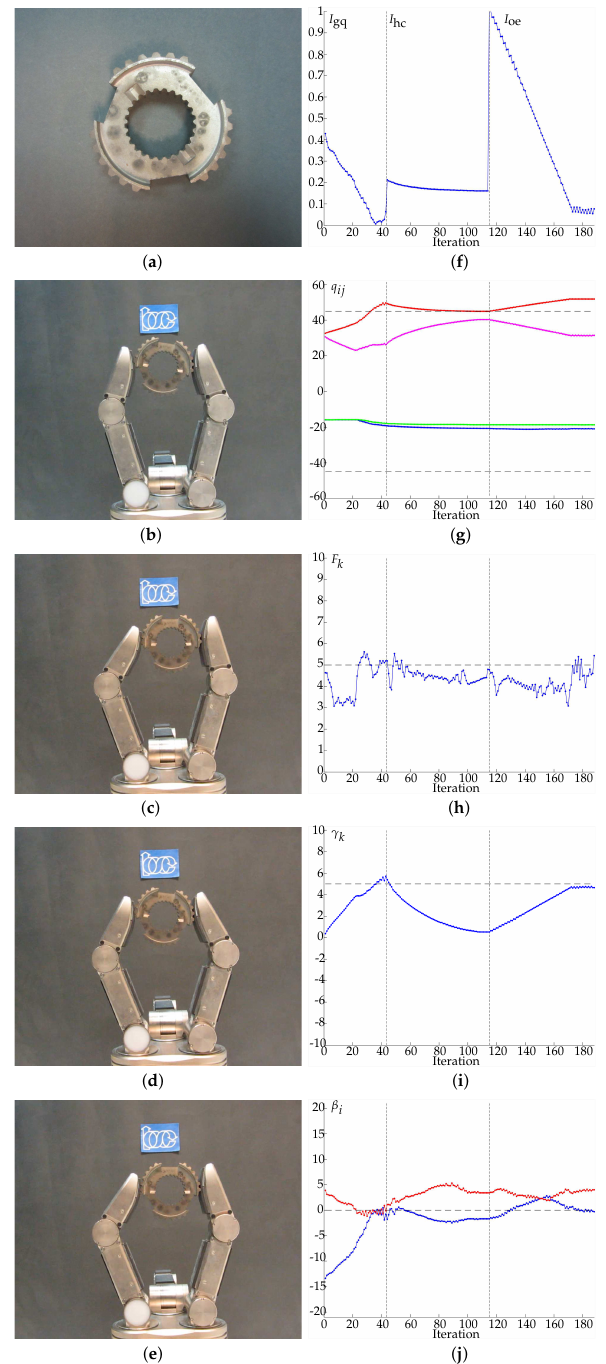
Figure 11. Example 1. ( a ) Manipulated object. ( b ) Initial grasp. ( c ) Hand configuration after optimizing I gq . ( d ) Hand configuration after optimizing I hc . ( e ) Hand configuration after optimizing I oe . ( f ) Evolution of the quality indexes. The manipulations improving I gq , I hc and I oe ended after 3.864 s and 43 iterations, 4.486 s and 70 iterations and 9.083 s and 73 iterations, respectively. ( g ) Evolution of the joints values in degrees, q 11 in blue, q 12 in red, q 21 in green, q 22 in magenta. ( h ) Average force F k in Newtons, the dashed line indicates F d . ( i ) Evolution of the object orientation in degrees. ( j ) Angles β i in degrees, β 1 in blue and β 2 in red (the dashed line indicates the optimal value of β i ). Note that the non-smooth and toothed surface of the manipulated object produces more than one contact region on each fingertip without generating any manipulation